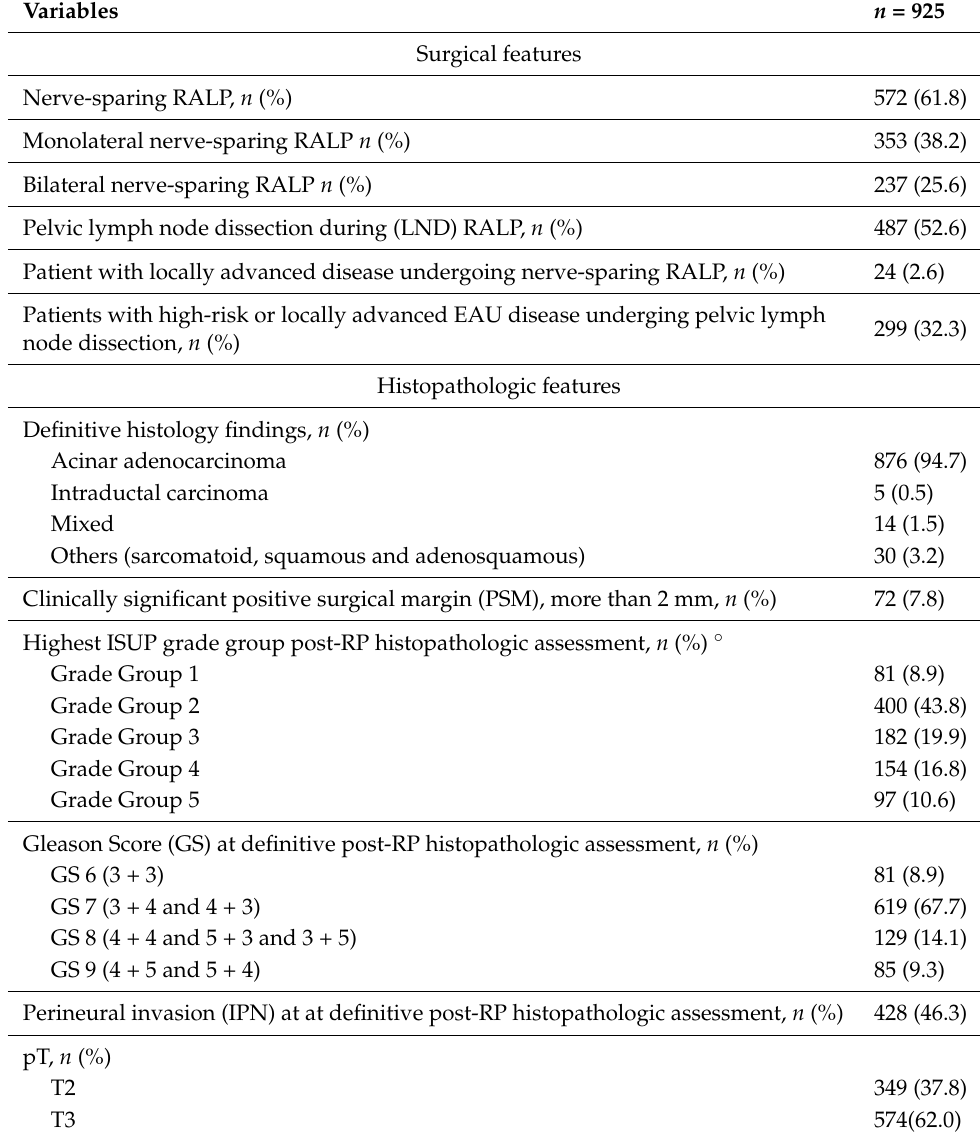
Table 2. Intra and histopathological features for the overall